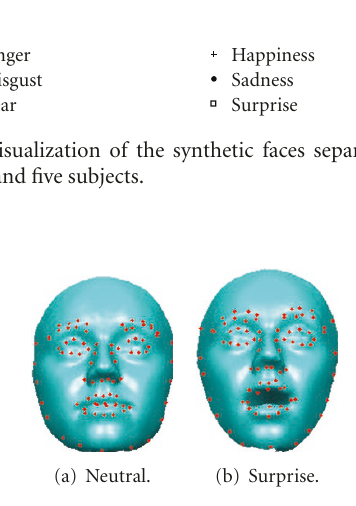
Figure 7: Example of manually selected landmarks in two di ff erent faces from the BU-3DFE